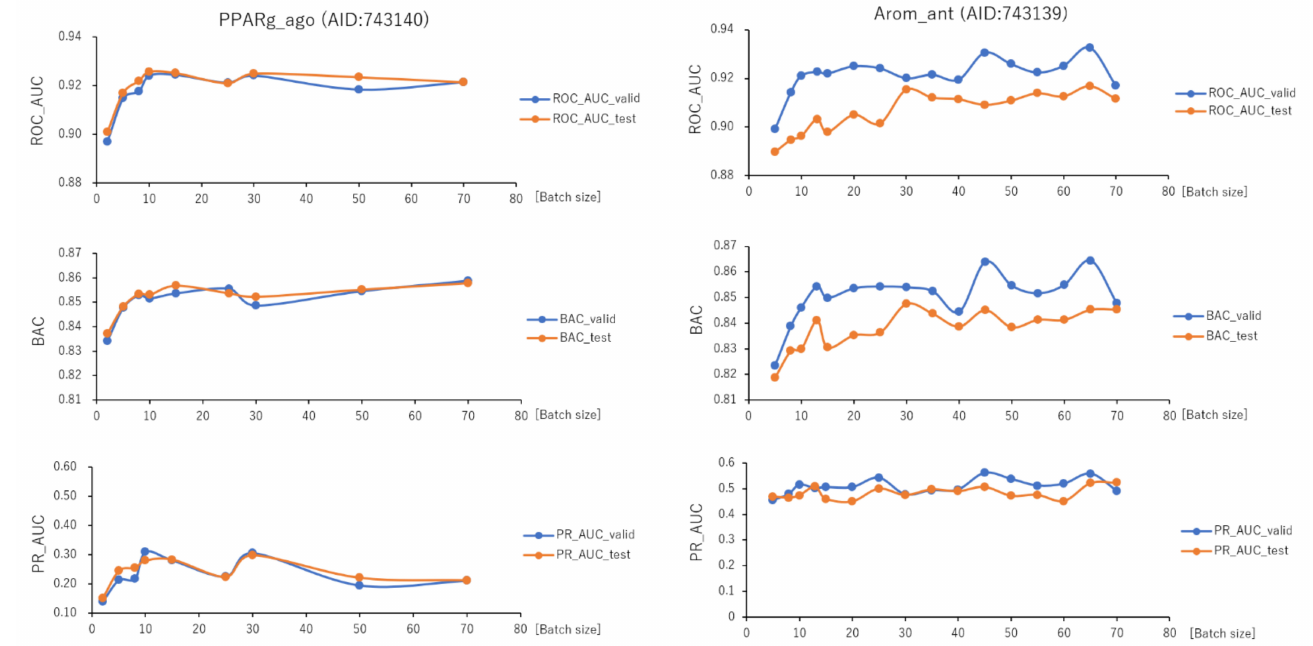
Figure 11. ROC_AUC, BAC, and PR_AUC for PPARg_ago (AID:743140) and Arom_ant (AID:743139) using TensorFlow with different batch sizes. Three-fold experiments were